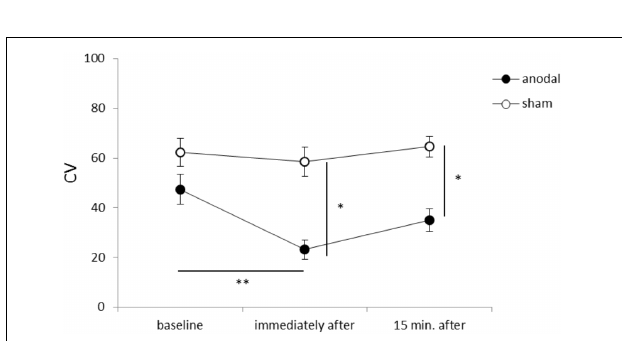
FIGURE 1 | (A) Electromyography waveforms in the biceps femoris (BF) during a self-paced rapid shoulder flexion task for a representative case. BF onset was defined as the point at which the EMG signal reached at least 3 standard deviations above the mean baseline. Data are shown representing the baseline stimulation condition (B) , immediately after stimulation (C) , and 15 min after stimulation (D) recorded from the representative subject. Electromyography waveforms were presented for the baseline stimulation condition in 10 trials of BF onset. Latency differences ( (cid:49) EMG onset) were calculated by subtracting the time of EMG burst onset of the BF (BF onset) from that of the activation onset of the deltoid anterior muscle (AD) (AD onset).